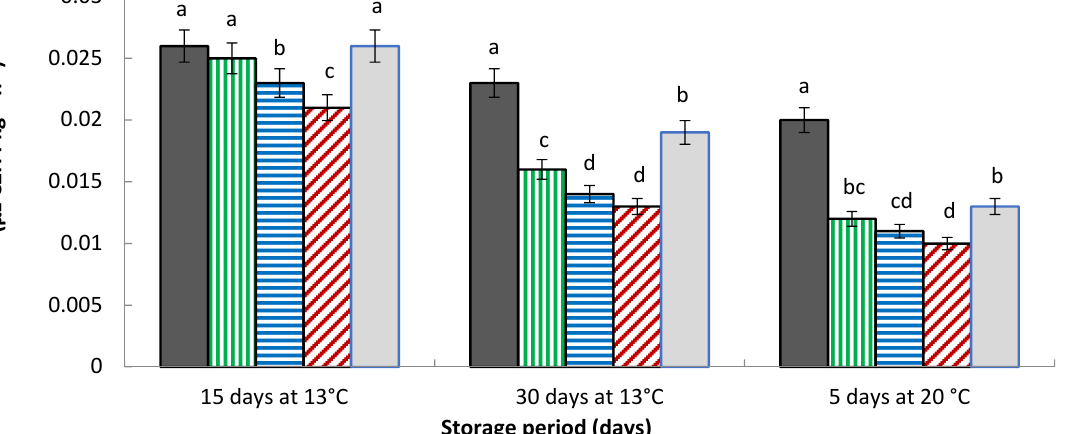
Figure 5. Ethylene production ( µ L C2H4 kg − 1 h − 1 ) as a mean of ‘Tommy Atkins’ mangoes from two seasons, stored at 13 ± 1 ◦ C and 90–95% RH for 30 days. Afterward, the fruits were stored at 20 ± 2 ◦ C and 70–75% RH for 5 days as the marketing period. Vertical bars indicate the standard error (SE) of the mean ( n = 5). The superscript letters followed by the same letters are not significantly different according to Duncan’s multiple range test at 0.05 level.